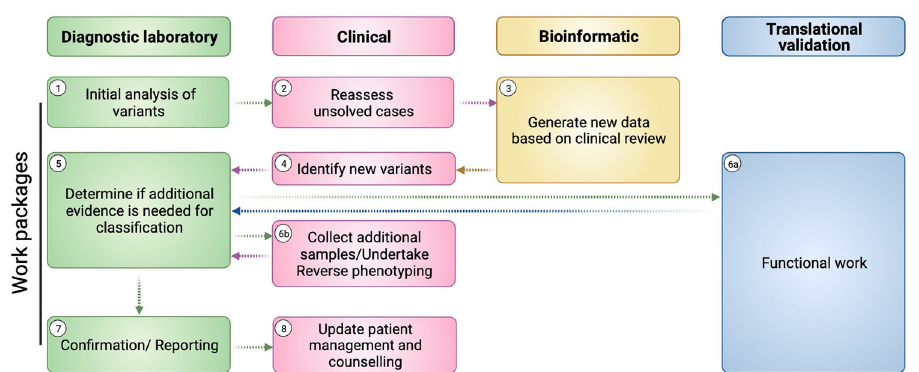
Fig.4|ModelforaspecialistgenomicMDT. Wesuggestthatanevolvedspecialist genomic MDT model is needed for complex cases. After initial analysis of variants (1),agenomicmedicineclinicianshouldre-evaluatethecase(2),anddatashouldbe updated to address the nuances of the patient presentation (3). The clinician can